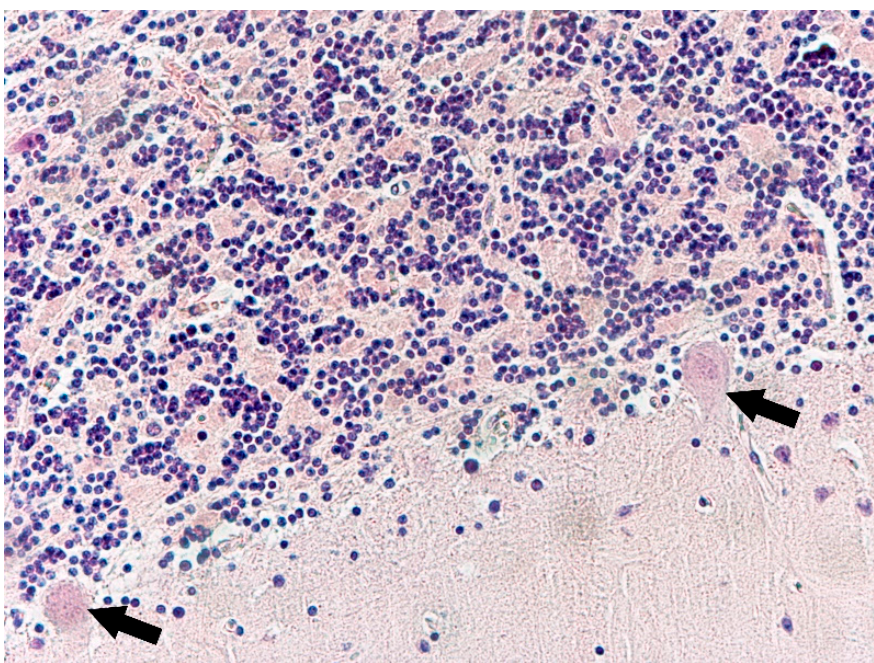
Figure 2. Case no. 1. Cerebellar cortex. Defects and homogenisation changes of Purkinje cells (arrows), Purkinje cells layer. Slight proliferation of Bergmann glial cells and loss of Purkinje cells. H&E staining, magnification 200×.